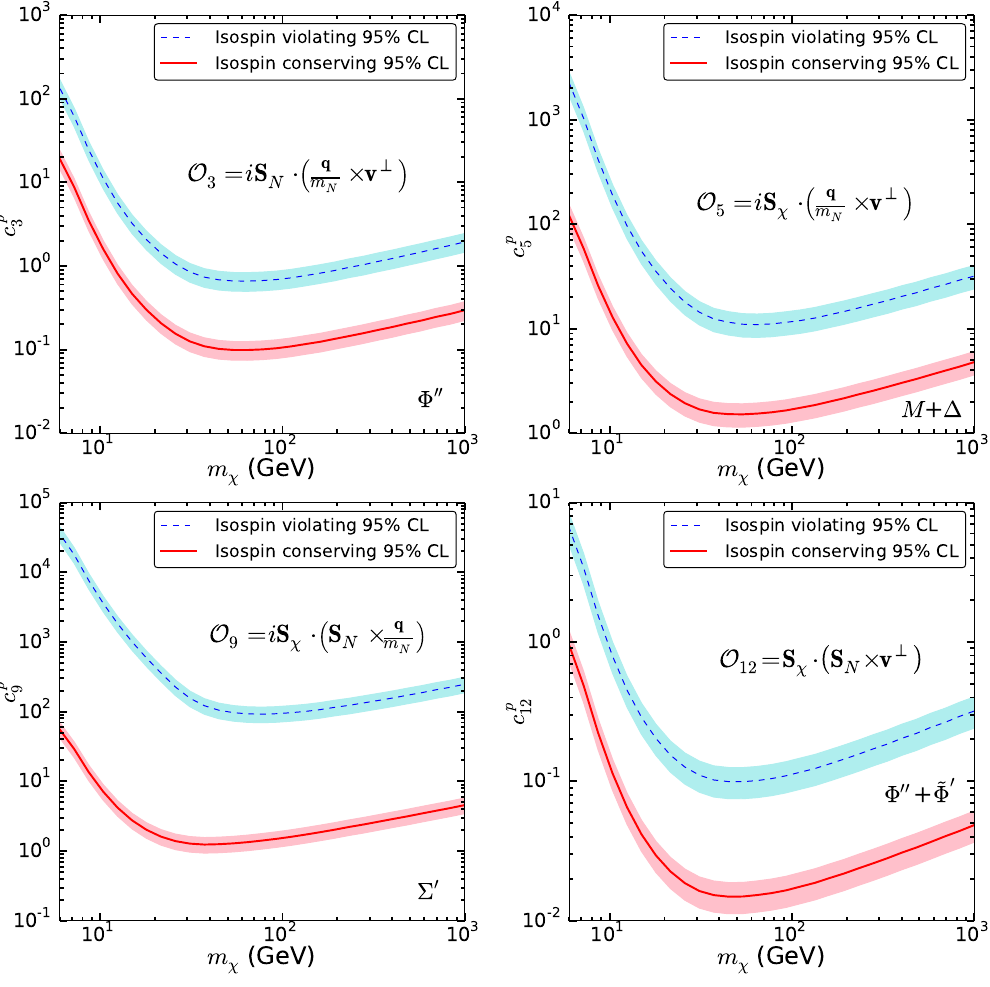
Figure 3 . Same as (cid:12)gure 2 but for operators O 3 , O 5 , O 9 and O 12